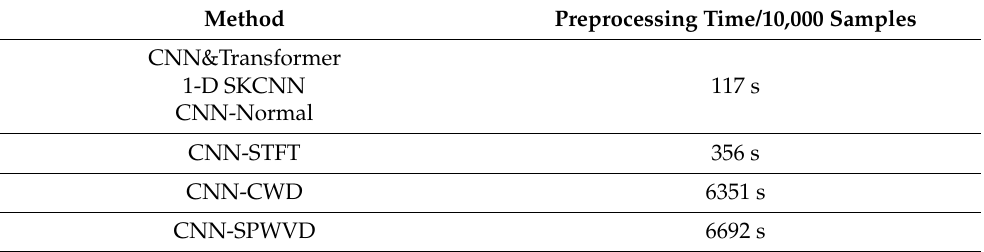
Table 7. The data preprocessing time between TFI-based methods and 1-D-model-based method.